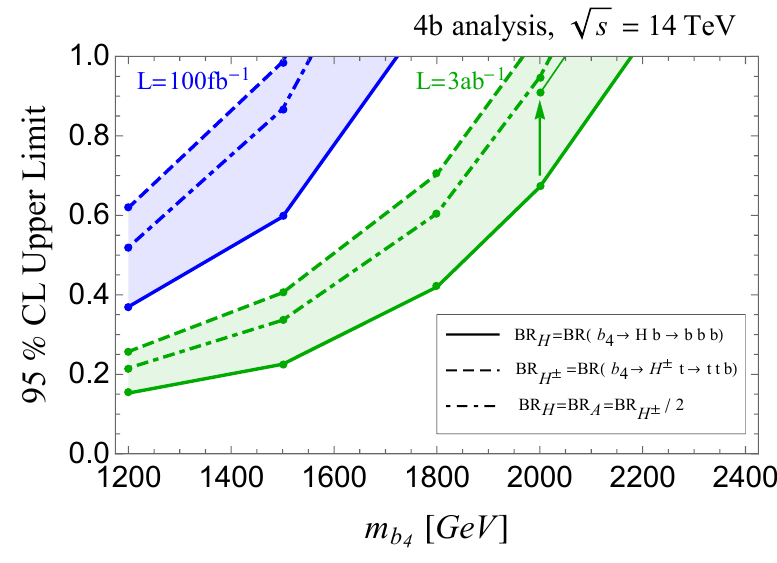
Figure 7 . Expected 95% CL upper limits on the b 4 branching ratio into neutral or charged Higgses Hb bbb decay mode are shown with the solid lines, in the 4b analysis. Upper limits for the b 4 ! ! H (cid:6) t ttb are shown with the dashed lines assuming m while those for the b 4 H;A;H (cid:6) = 1 TeV. ! ! The dot-dashed lines give the limits when all heavy Higgs decay with typical patterns of branching ratios for a singlet-like b 4 as discussed in section 2 with m H;A;H (cid:6) = 1 TeV. The thinner line with the arrow indicate the corresponding limit when m H;A;H (cid:6) = m b 200 GeV. 4 (cid:0)